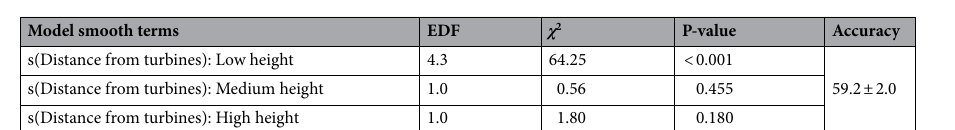
Table 1. Summary statistics of a binomial Generalized Additive Mixed Model (GAMM) relating the probability of birds to be oriented towards wind turbines to their distance to the nearest turbine and flight height. The response variable was assigned to 1 if the bird’s flight heading deviated less than 60° from the bearing to the nearest turbine or 0 otherwise. Flight height was classified into three classes: Low height (up to the maximum turbine height); Medium height (from the maximum turbine height to the height of two turbines); High height (higher than the upper limit of the medium height class). Bird identity was included as a random effect. Model accuracy is represented as the average and standard deviation of the percentage of correct predictions of 10 cross-validation models. EDF estimated degrees of freedom, χ 2 Chi-square